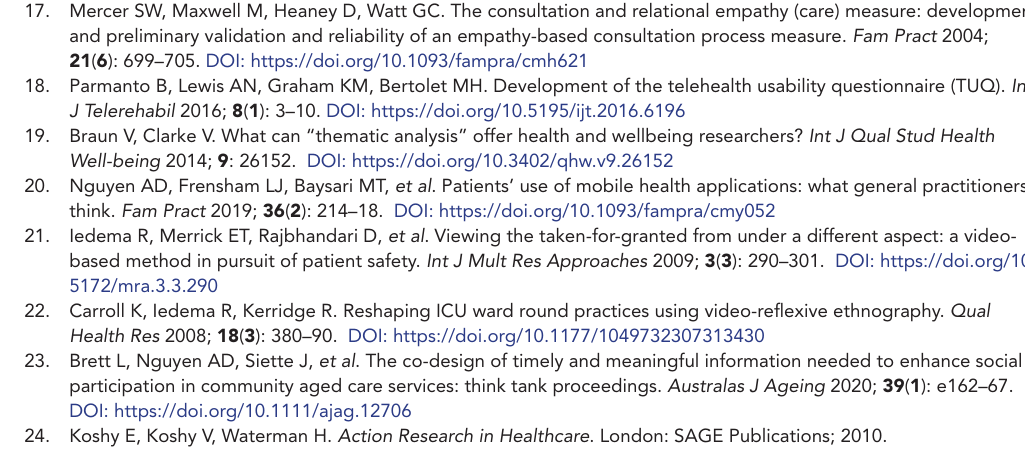
White SJ et al . BJGP Open 2022; DOI: